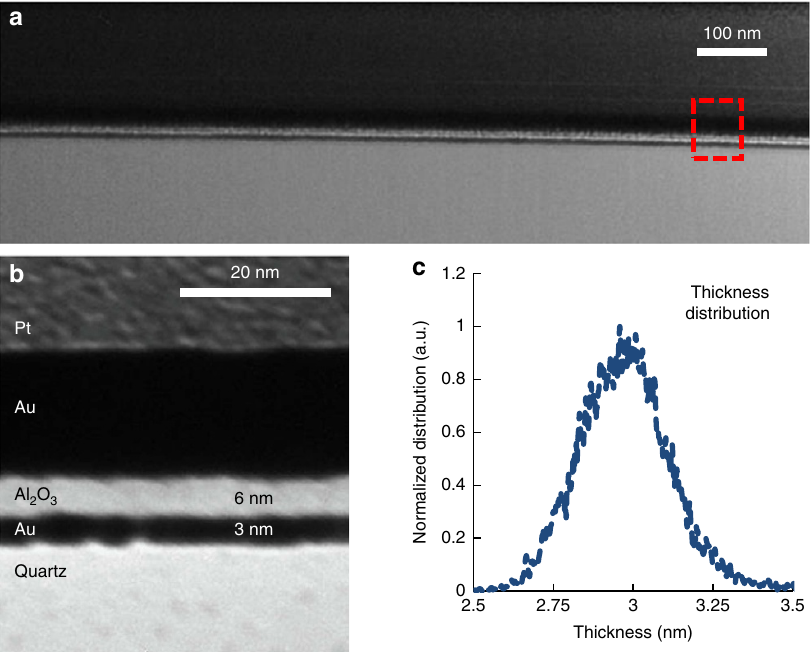
Figure 1 | Sample characterization. ( a ) Cross-sectional TEM image of the MQW sample prepared by focused ion beam (FIB). ( b ) A zoomed-in view of the MQW, that is, the bottom Au layer, indicates that the gold film is continuous. The thick Au and Pt layers atop were only used to facilitate the FIB process. ( c ) Statistics of the film thickness variations obtained from AFM measurement right after 3nm gold film growth on the quartz substrate but before the Al 2 O 3 film deposition. The surface roughness is around ±